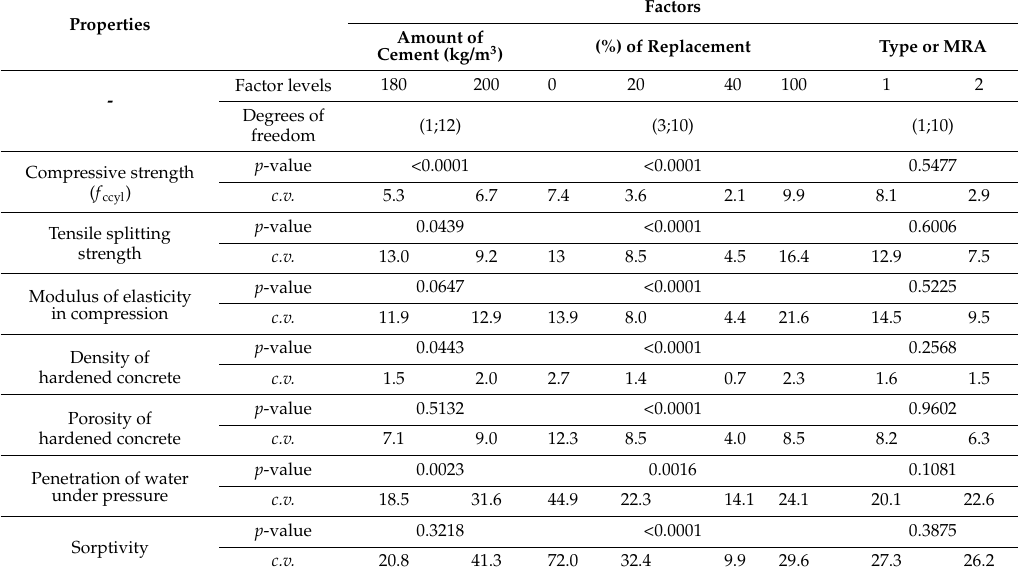
Table 8. Summary results of ANOVA and coefficient of variation.